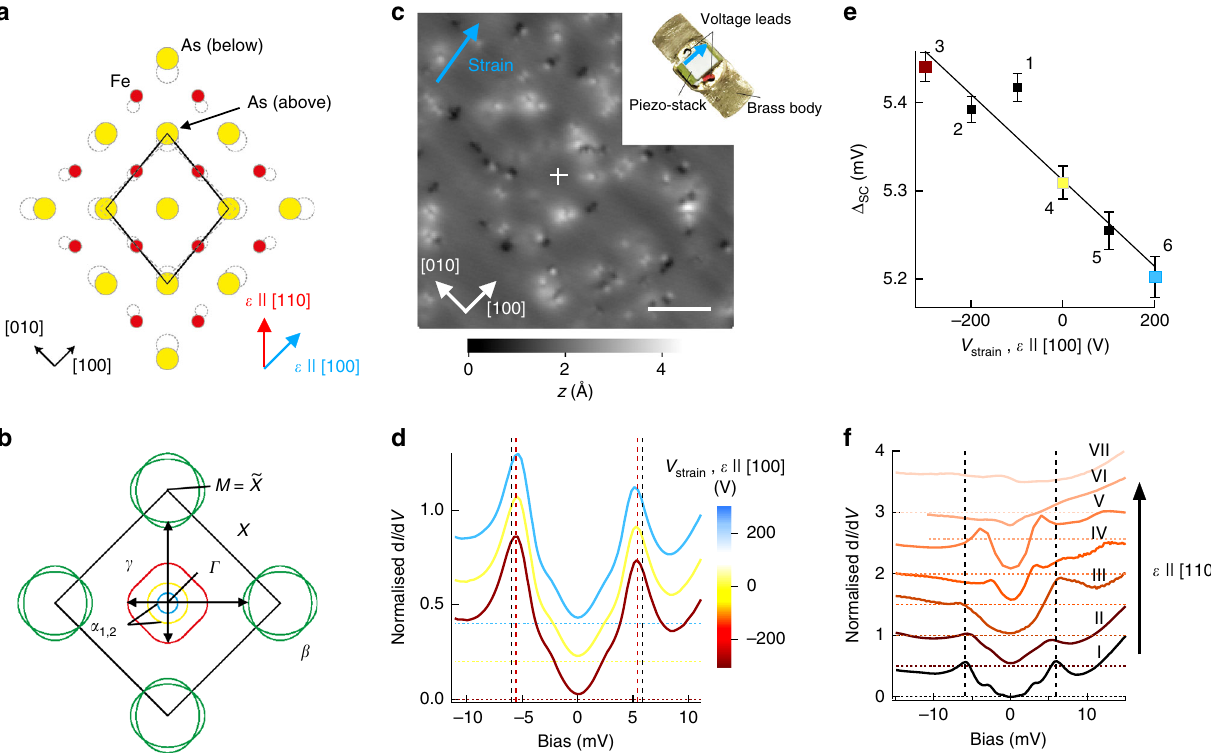
Fig. 1 Tuning superconductivity in LiFeAs by uniaxial strain. a Ball model of the LiFeAs unit cell under positive uniaxial strain along the [110] direction. Dashed open circles represent the atomic positions in the unstrained unit cell, red and blue arrows indicate strain direction along [110] and [100]. b Fermi surface of unstrained LiFeAs. Arrows indicate nesting vectors Q between hole bands at the zone centre and electron bands at the zone corner. c Topographic image of LiFeAs strained along [100] (setpoint conditions V s = 20 mV, I s = 50 pA, T = 4 K). A blue arrow indicates the strain direction. Scale bar = 4.3 nm. Inset, sample holder for in-situ strain tuning (without sample). An arrow indicates the direction of strain. d d I /d V spectra obtained at the position marked with a cross in ( c ) with strain along [100] at different voltages V strain applied to the piezo stack, showing the superconducting gap ( V s = 14 mV, I s = 0.5 nA, T = 4.2 K, spectra are normalised at V = 14 mV). Brown-red dashed vertical lines indicate the positions of the coherence peaks for the spectrum obtained at V strain = − 300 V, black dashed vertical lines for unstrained LiFeAs. e Plot of gap size Δ SC versus V strain extracted from d (see also Supplementary Note 1, Supplementary Figure S7). The number near each data point indicates the order in which the spectra were taken. Error bars of the gap size are obtained from the non-linear least squares fi t to the experimental data in d and represent the 1 σ con fi dence interval. For unstrained LiFeAs, Δ = 5.8 meV at T = 4.2 K, outside the range of the graph. f d I /d V spectra on samples strained along [110]. Spectra from bottom to top are shown in order SC of increasing strain. The bottom curve is for an unstrained crystal. All spectra are normalised at V = 15 mV and vertically offset for clarity. Vertical lines indicate the energy of the coherence peaks for the unstrained crystal. Horizontal lines in d , f indicate zero conductance for each of the